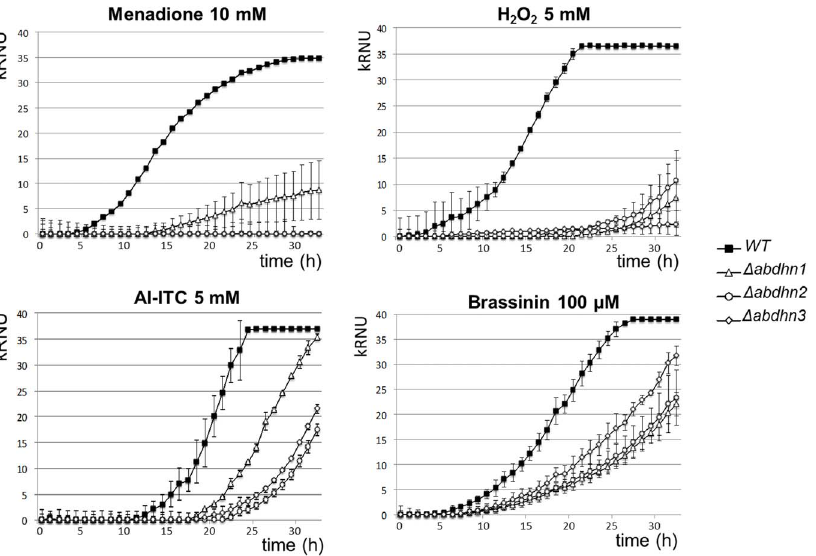
Figure 8. Susceptibility of AbDhn-deficient mutants to oxidative stress. Nephelometric monitoring of growth of wild-type strain (black symbols) and AbDhn-deficient mutants (open symbols; D abdhn1 : triangles, D abdhn2 : circles, D abdh3 : diamonds) was automatically recorded for 33 h at 24 u C. The unit of the Y-axis corresponds to the Relative Nephelometric Unit (RNU). Conidia were used to inoculate microplate wells containing standard PDB medium that was supplemented with either 10 mM menadione, 5 mM H 2 O 2 , 5 mM Al-ITC or 100 m M brassinin. Error bars indicate standard deviations. Each genotype was analysed in triplicate and the experiments were repeated twice times per growth condition. Lag time and maximal growth rate variables were calculated from the growth curves using a calculation method described by Joubert et al. [19]. For each parameter, Student’s T-test was used to assess significant difference between the treated and untreated samples or between mutants and parental